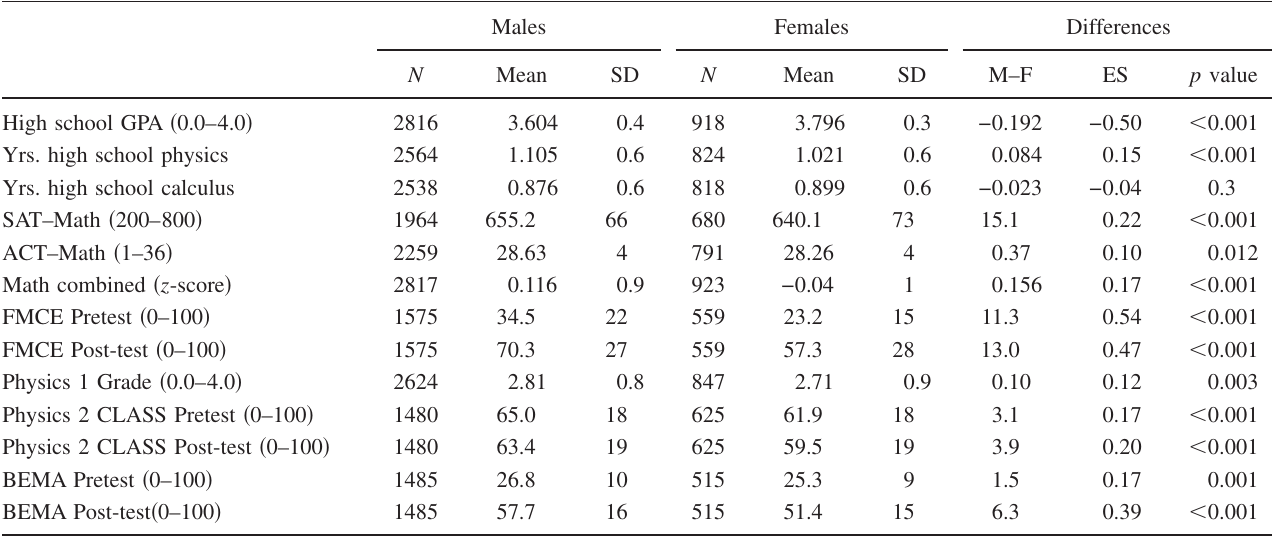
TABLE VII. Male and female average values for variables that were collected. The range of possible scores for each variable is shown in parentheses. The effect size is calculated as ES = (cid:1)(cid:5) S (cid:6) M – (cid:5) S (cid:6) F (cid:2) / SD , where the SD for all students is used. Significant differences exist between males and females on almost all of the variables.